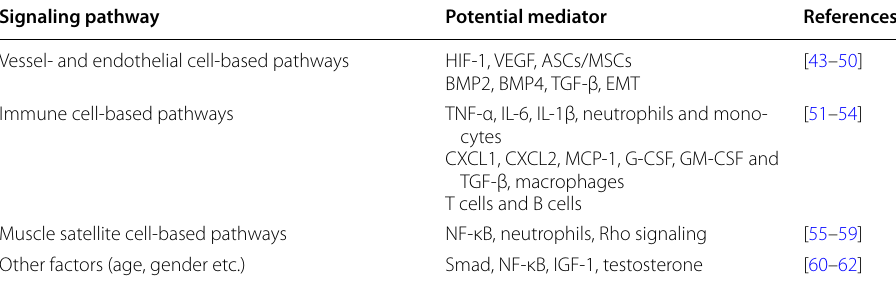
Other factors (age, gender